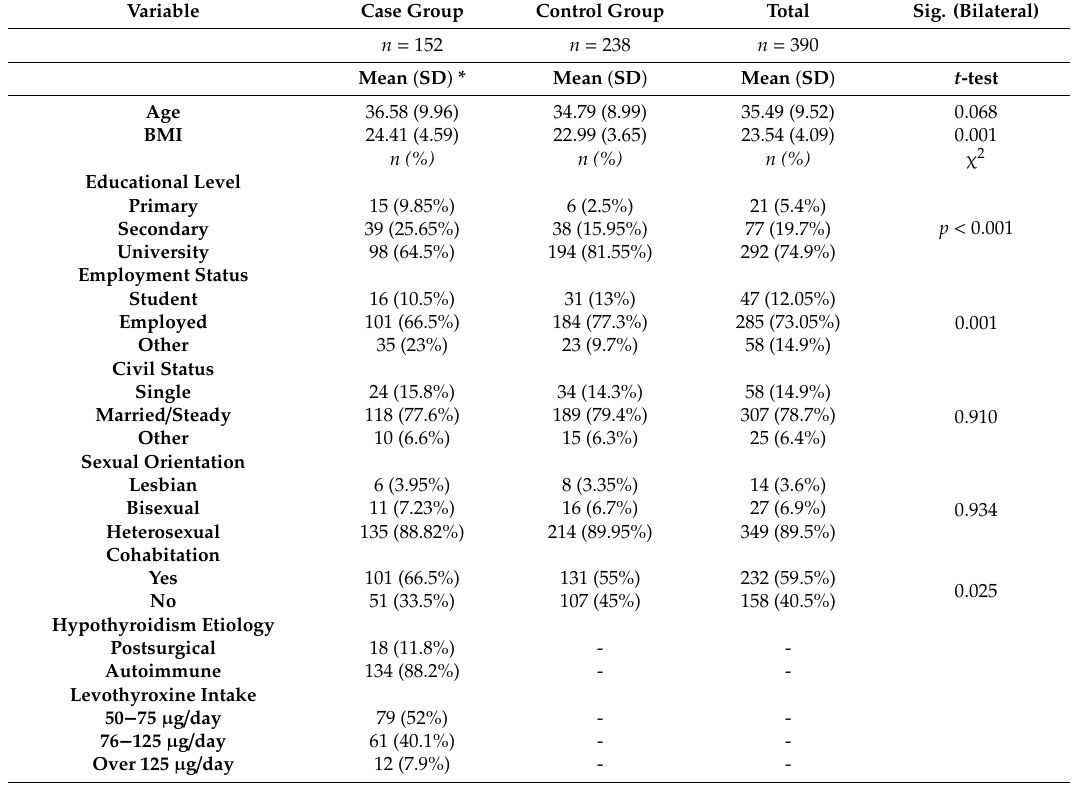
Table 1. Socio-demographic and clinical